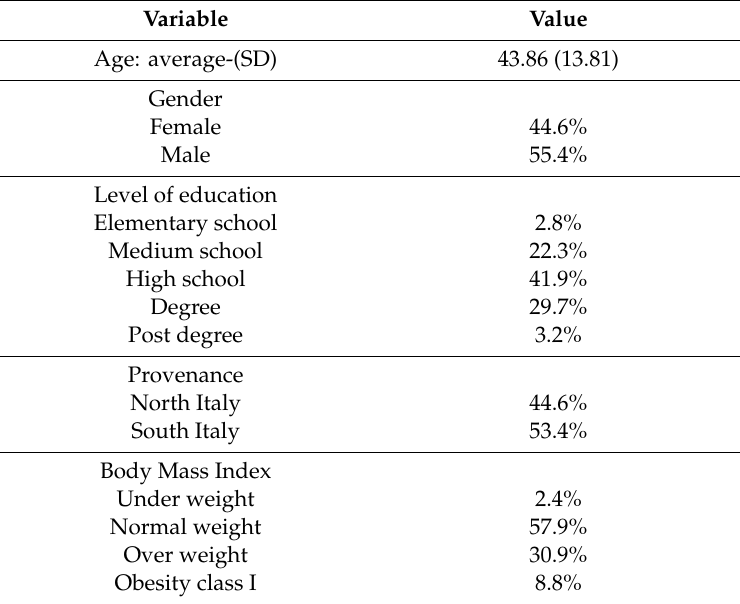
Table 1. Socio-demographic statistics of the validated sample ( n =